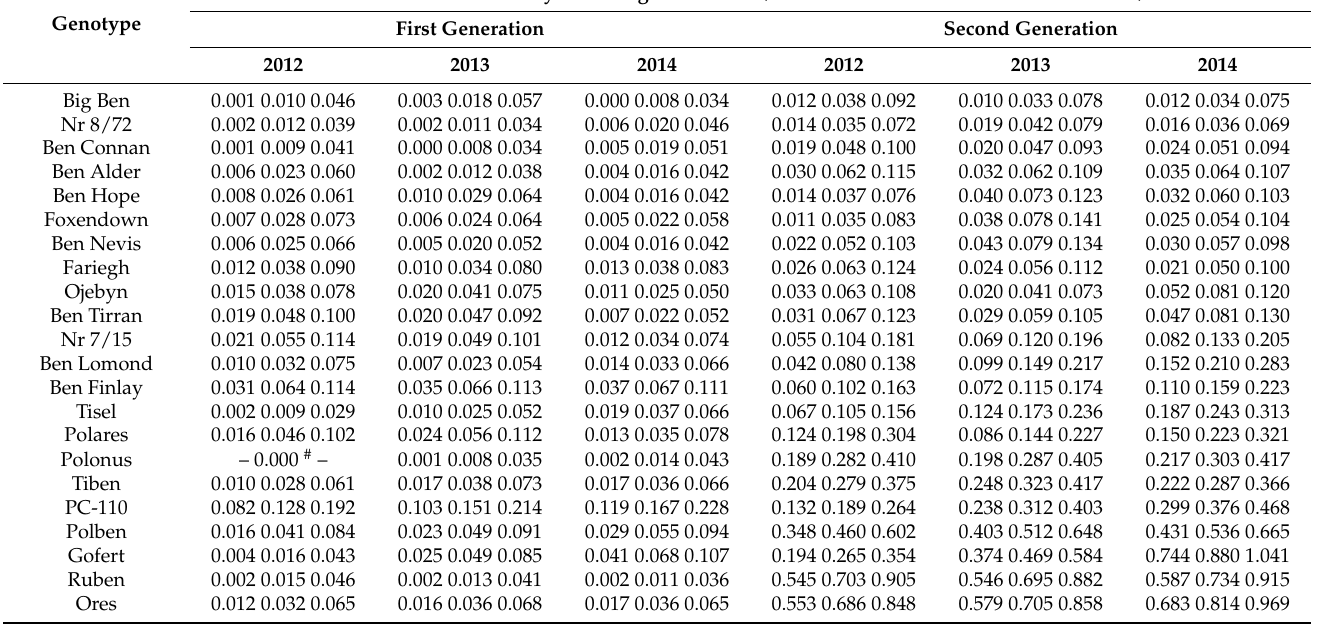
Table 2. Probability of shoot damage per genotype. The cells show estimates with 95% confidence intervals estimated using generalized linear models. The genotypes are sorted according to the increasing mean probability across the three years and both pest